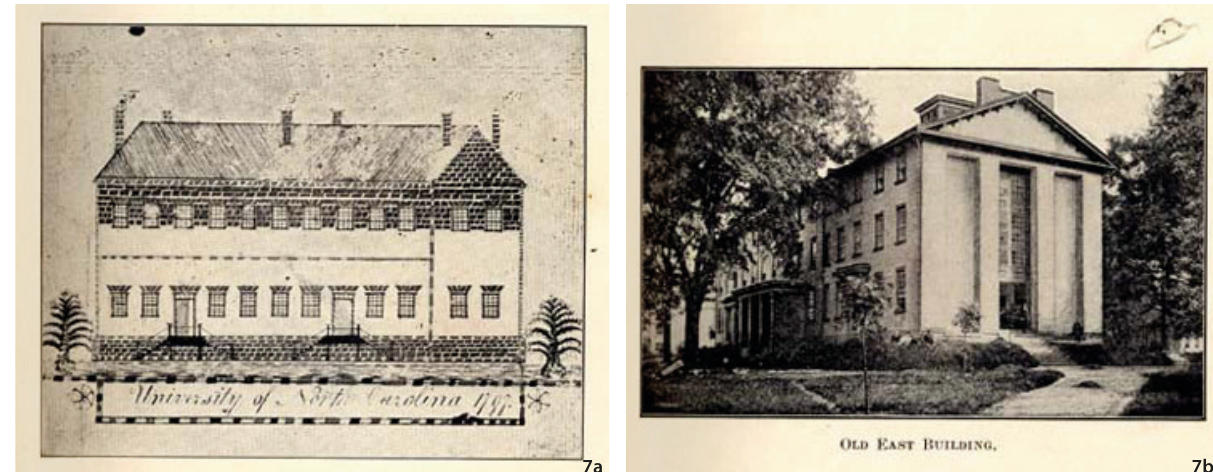
Figure 7a Old East, University of North Carolina, Chapel Hill, North Carolina. The drawing depicts how Old East appeared when it was first built in 1795 (Source: The University of North Carolina Archives, Chapel Hill, North Carolina). Figure 7b Old East, University of North Carolina, Chapel Hill, North Carolina. The photograph, taken in 1880, depicts the northern addition designed by Alexander Jackson Davis in 1842 (Source: The University of North Carolina Archives, Chapel Hill, North